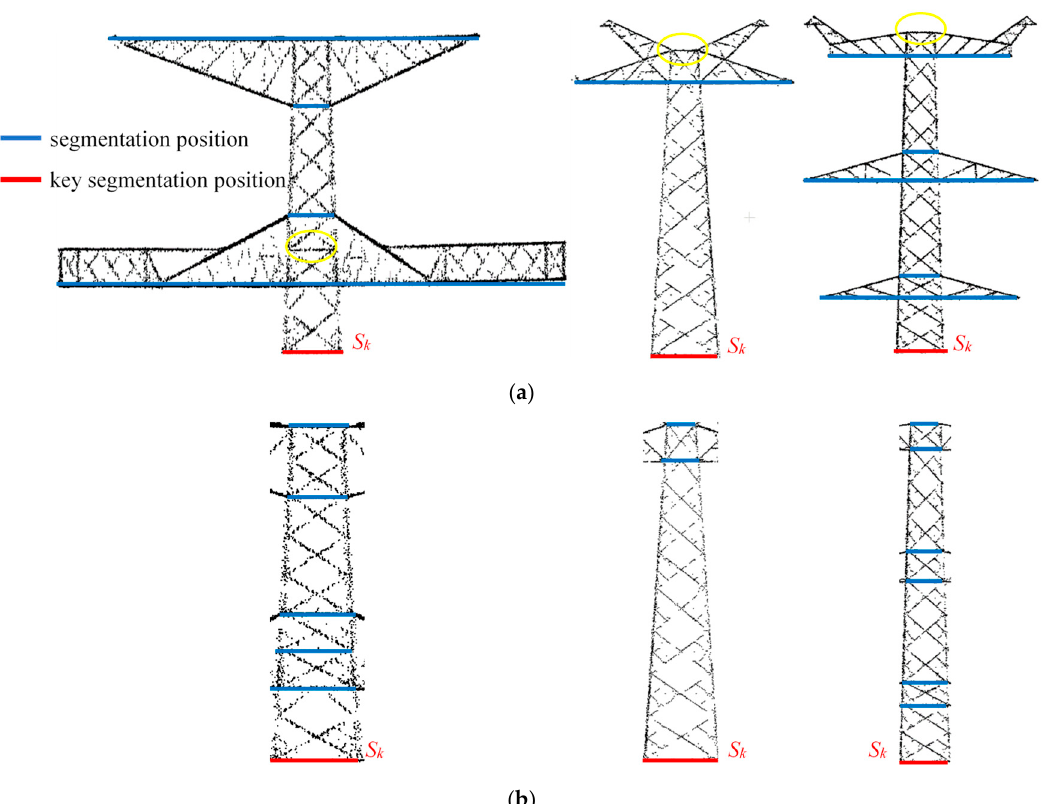
Figure 9. The type of partial pylons: ( a ) Segmentation positions detection exception; ( b ) points after interference points are removed.